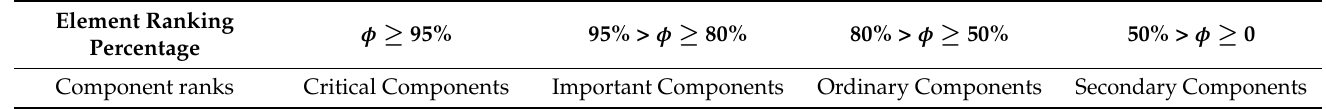
Table 1. The importance ranking of the structural